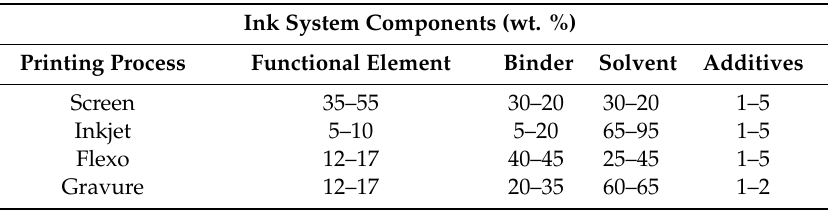
Table 2. Di ff erent components present in the ink